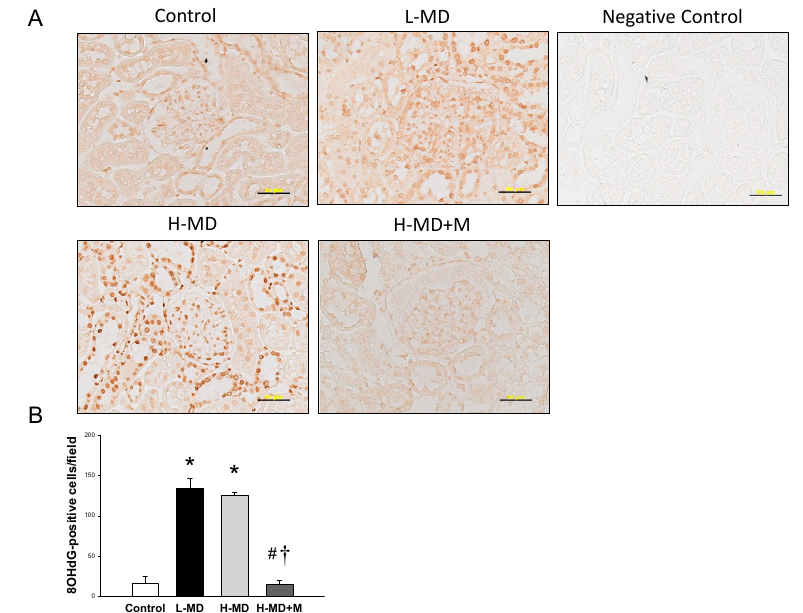
Figure 4. ( A ) Light micrographs illustrating immunostaining for 8-hydroxydeoxyguanosine (8-OHdG) in the kidney of 12-week-old male offspring exposed to a maternal methyl-deficient diet (L-MD), high methyl-donor diet (H-MD), and high methyl-donor diet plus melatonin therapy (H-MD+M). Bar = 50 µ m. ( B ) Quantitative analysis of 8-OHdG-positive cells per microscopic field ( × 400). * p < 0.05 vs. control; # p < 0.05 vs. L-MD; † p < 0.05 vs. H-MD. n =